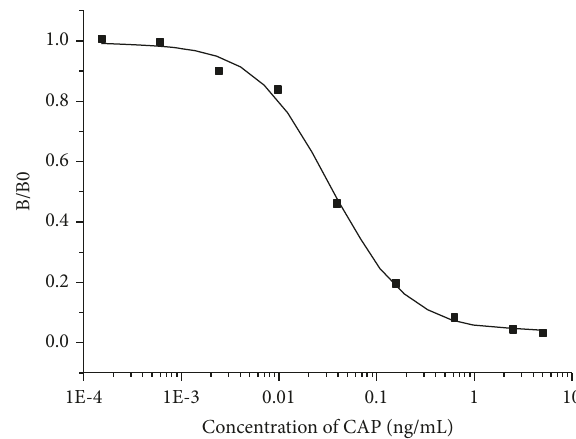
Figure 3: Standard curve for CAP generated from the CL-ELISA under the optimized